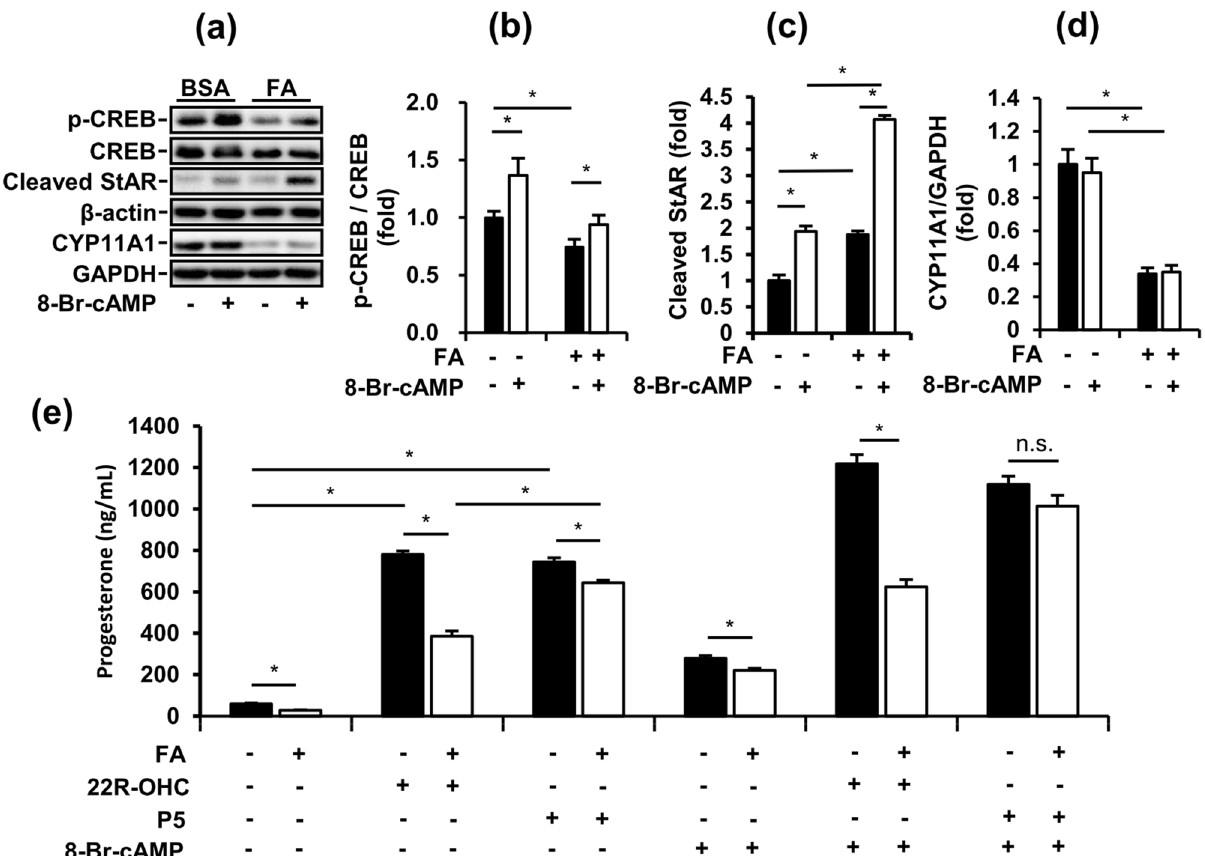
Figure 2. Fatty acid-suppressed steroidogenesis through impaired steroidogenic signaling is largely recovered by P5 treatment in MA-10 cells. ( a ) Representative blots in FA-induced MA-10 cells after 4-h 8-Br-cAMP treatment are shown. ( b ), ( c ), ( d ) Quantifications of blots normalized by β-actin or GAPDH are shown as means ± SEM (n = 3). ( e ) The progesterone levels from FA-induced MA-10 cells treated with or without 50 µM 8-Br-cAMP, 1 µg/mL of P5 and 10 µg/mL of 22R-OHC for 4 additional hours. The data are represented as means ± SEM (n = 3). *P < 0.05. n.s.: no significant